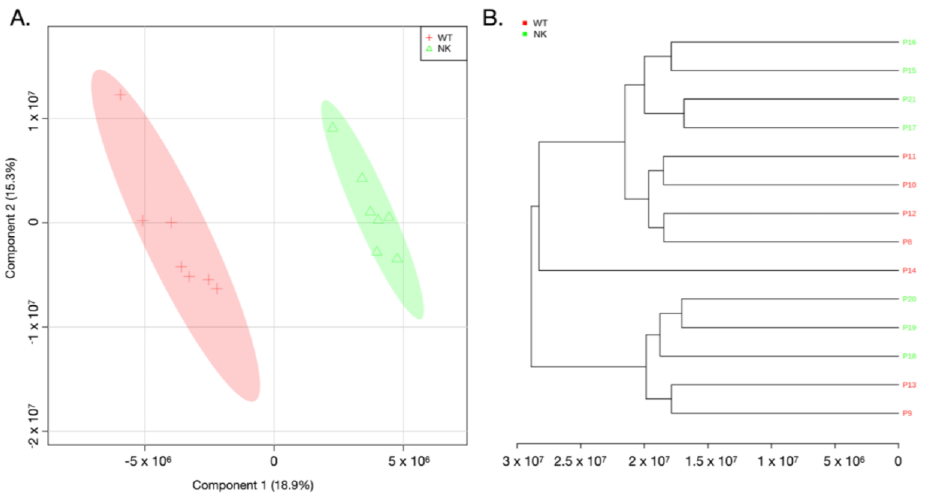
Figure 3. ( A ) PLS-DA score plot in 2D of the HR-MAS 1 H-NMR CPMG data, showing 14 paired tissue samples, 7 WT and 7 NK. The WT tissue samples are shown with red crosses and the normal kidney (NK) tissue samples are shown with green triangles. Accuracy: 0.774, R 2 : 0.902, and Q 2 : 0.430. The VIP scores greater than 2.7 corresponded to metabolites from the aliphatic region (0.50 to 4.50 ppm, metabolites 1–9 and 11–13, see Figures 1 and 4). ( B ) Hierarchical Cluster Analysis (HCA) shows a graphical representation of the PCA scores for component 1 (describing 17.1% of the total variance) plotted against component 2 (13% of the total variance) and shows the similarities or differences among the tissue samples, wherein the samples that form clusters show similarities, and samples that are found at greater distances are dissimilar. The WT P14 is a unique sample with incidence of metastasis. NK samples P18 and P19 were from the patients with WT clinical stage III. Similarities were observed among the WT samples and among the WT and NK samples from the same